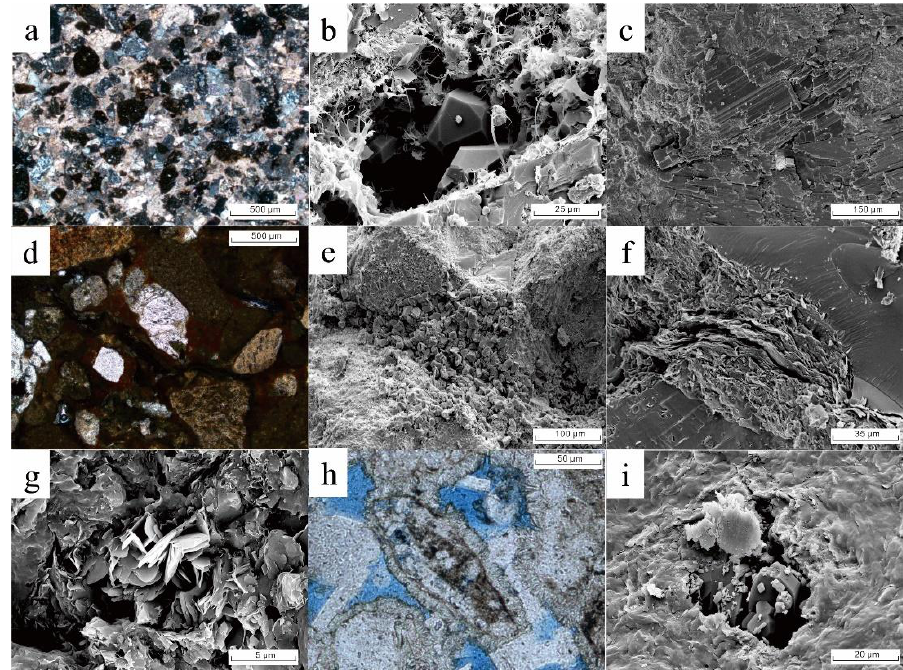
Figure 5. Thin sections and SEM images of cementation in study area. ( a ) thin section of well YT1, 5044 m, Lower Wuerhe formation, strong calcite cementation; ( b ) SEM image of well MZ2, 4199.36 m, Baikouquan formation, intergranular filling of authigenic quartz and filamentous illite; ( c ) SEM image of well M217, 4000.39 m, Lower Wuerhe formation, intergranular filling of zeolite; ( d ) thin section of well M217, Lower Wuerhe formation, heulandite cementation; ( e ) SEM image of well D11, 4280.63 m, Baikouquan formation, intergranular filling of worm-like kaolinite; ( f ) SEM image of well D11, 4294.47 m, Baikouquan formation, intergranular filling of lineated flaky illite; ( g ) SEM image of well M217, 4004.56 m, Lower Wuerhe formation, intragranular dissolved pores filling of leaf-shaped chlorite; ( h ) cast thin section of well YT1, 4872.5 m, Lower Wuerhe formation, authigenic sodium feldspar in intergranular pores and chlorite film developed; ( i ) SEM image of well MZ2, 4283.04 m, Baikouquan formation, intragranular dissolved pores filling of sodium feldspar